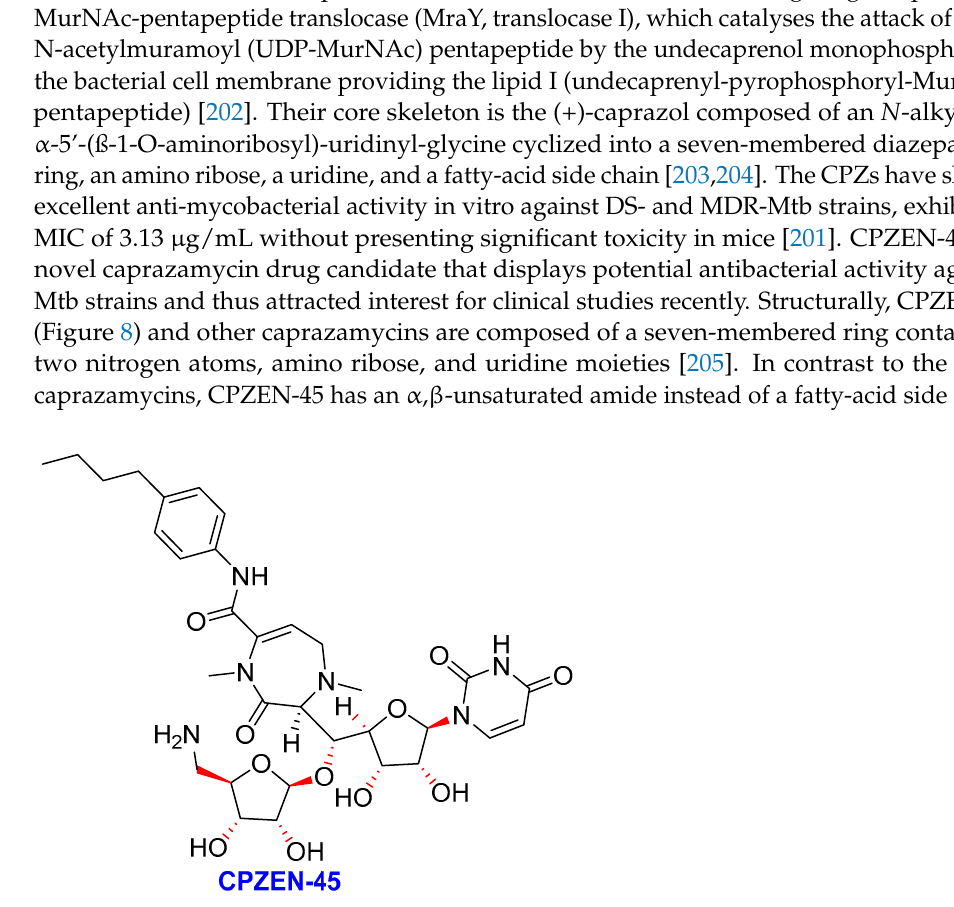
Figure 8. The chemical structure of CPZEN-45, a potential drug candidate for TB therapy. (i) Caprezene-4-butylanilide (CPZEN-45)